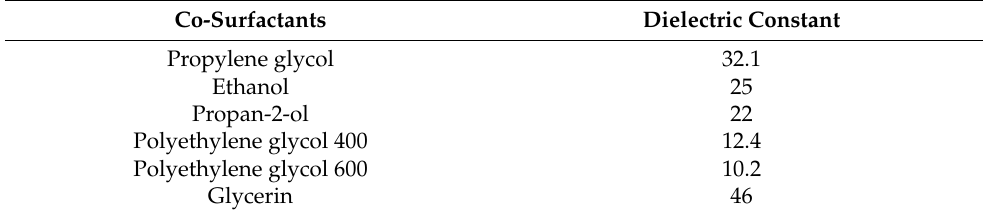
Figure 4. Chemical structures of ethanol ( a ), propan-2-ol ( b ), PG ( c ), glycerin ( d ), and PEG ( e ). Table 2. Dielectric constant ( δ ) of co-surfactant at 20 ◦